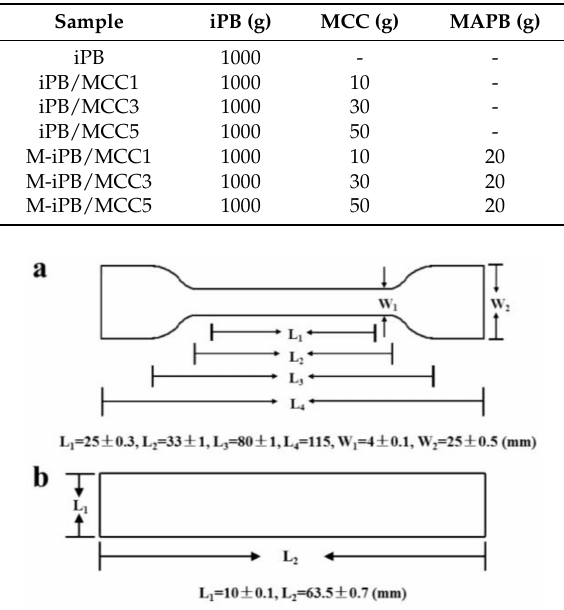
Figure 1. Standard test specimen size. ( a ) for tensile properties test; ( b ) for impact strength, flexural properties and heat-distortion temperature